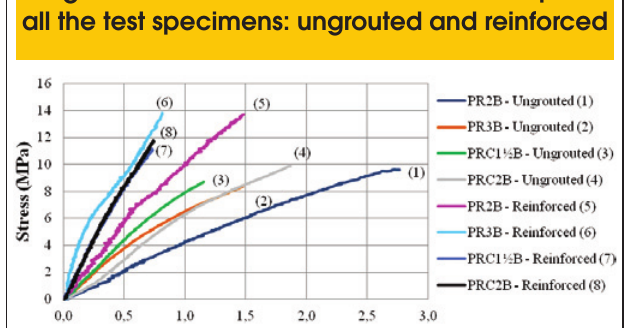
Figure 14 – Stress - strain diagram of the